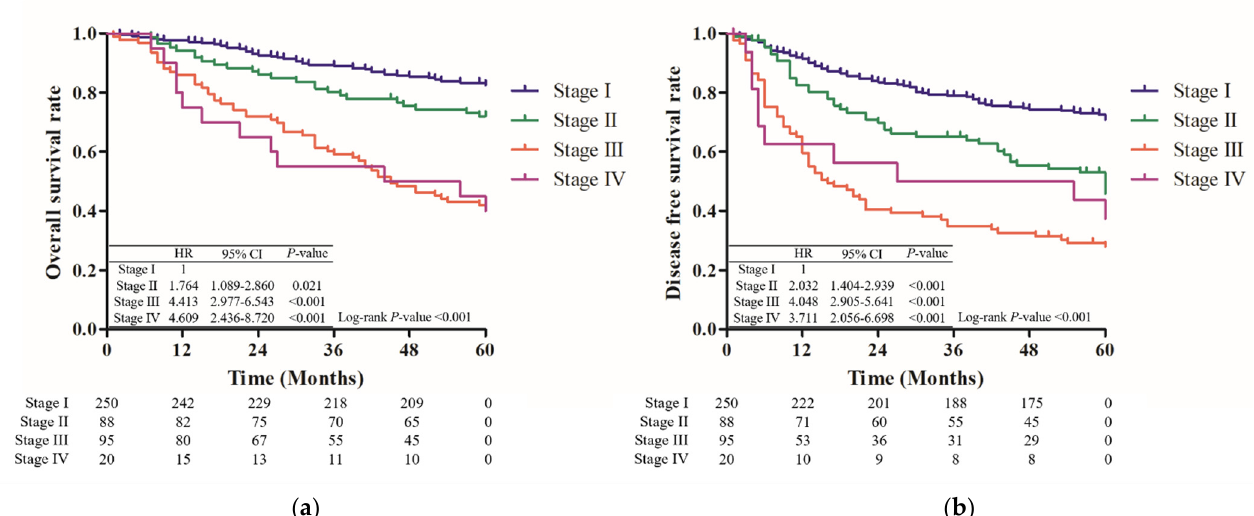
Figure 1. Overall survival and disease-free survival according to pathological stage. ( a ) Five-year overall survival according to pathologic stage. ( b ) Five-year disease-free survival according to pathological stage.